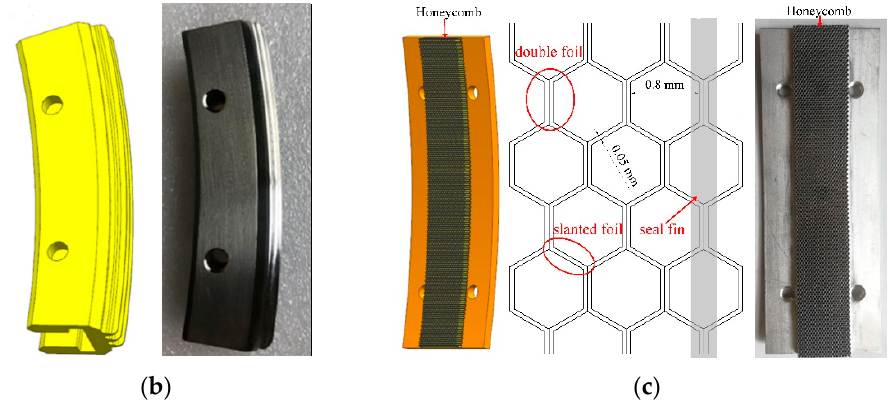
Figure 3. ( a ) The geometries of seal fins; ( b ) the seal fin sample and; ( c ) the honeycomb sample and honeycomb structure.